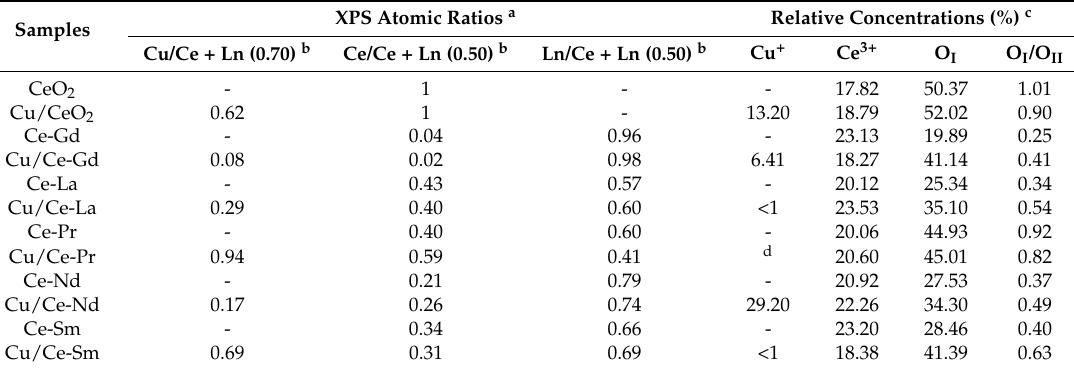
Table 2. Surface characteristics (determined by XPS) of Ce-Ln and Cu/Ce-Ln (Ln: Gd, La, Pr, Nd, Sm) materials.